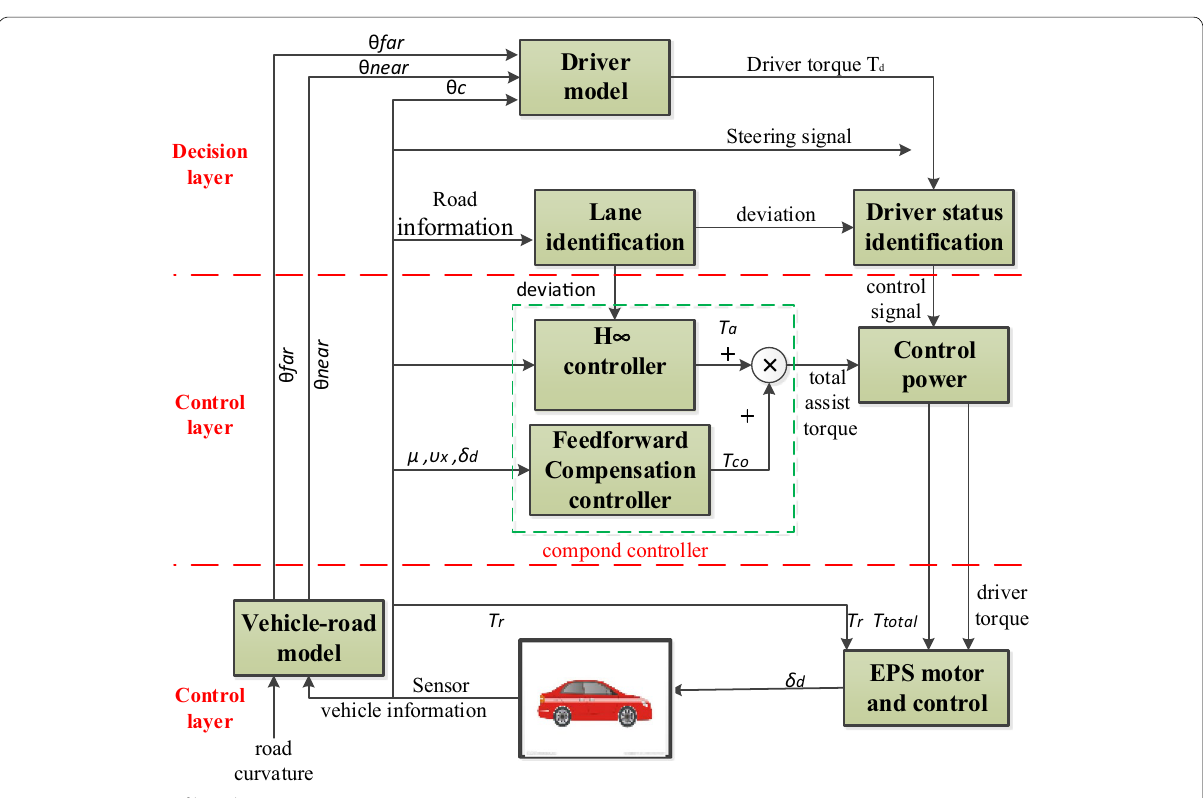
Figure 4 Structure of lane-keeping